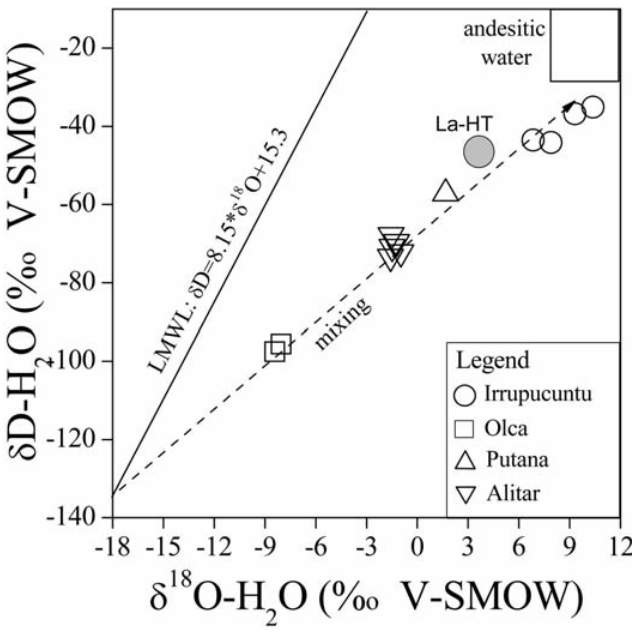
Figure 8. d 2 H versus d 18 O binary diagram. The "andesitic water" field [Taran et al. 1989, Giggenbach 1992b], and the local meteoric water line (LMWL: d 2 H = 8.15 d 18 O +15.3) [Chaffaut et al. 1998] are also shown. Symbols as in legend to Figure 6. For comparison, the isotopic composition of Lascar gases (La-HT) [Tassi et al. 2009] is also